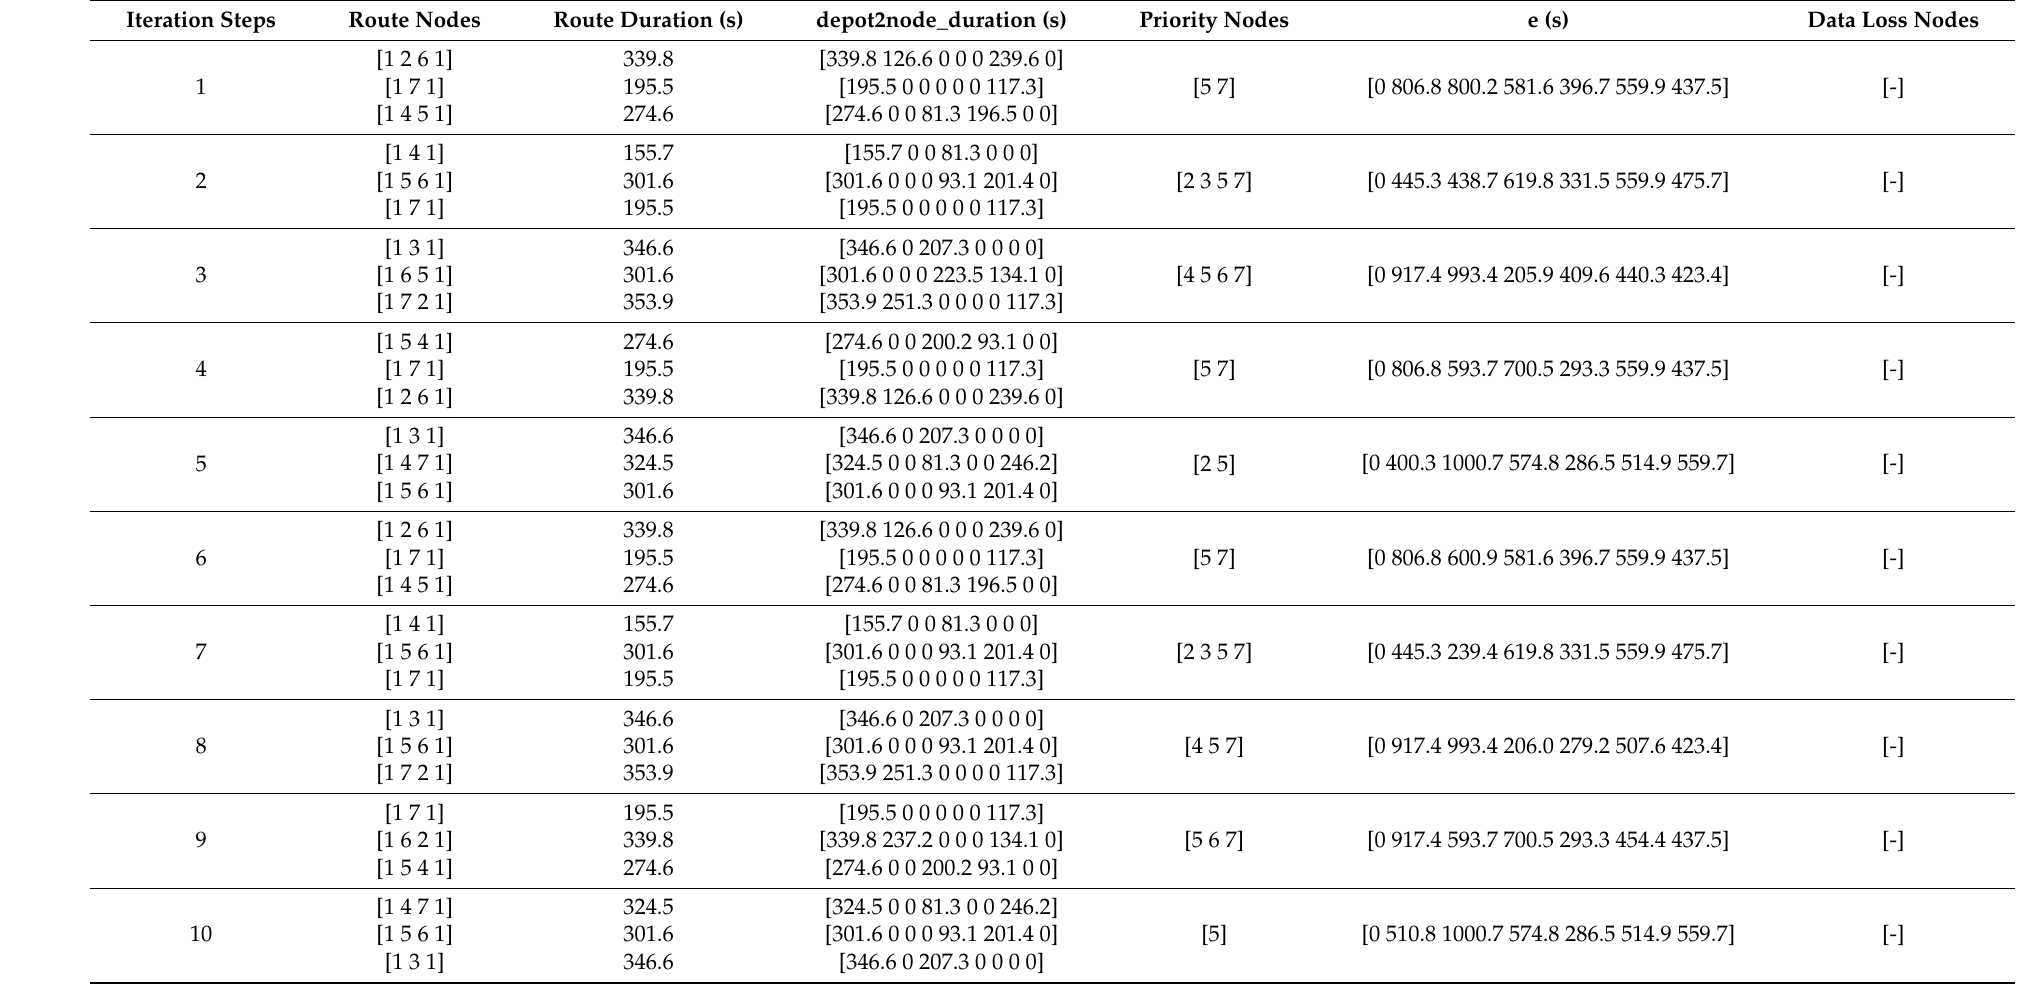
Table 2. MES Routes Results for 7 Static Nodes and 3